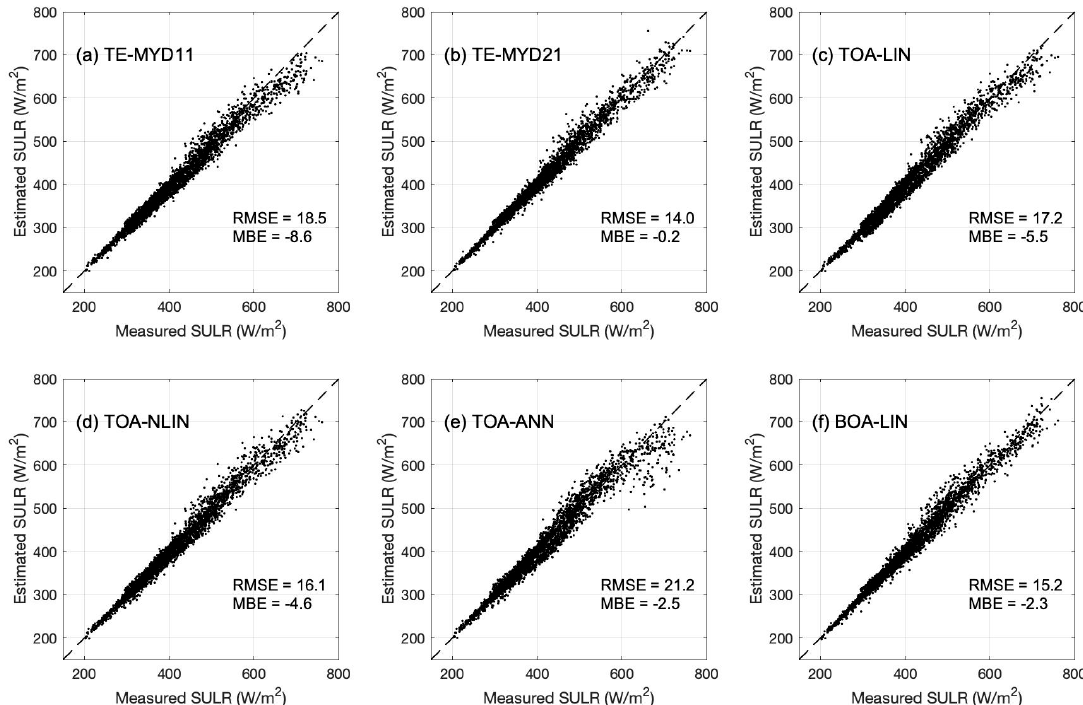
Figure 5. Scatterplots between estimated SULR and corresponding in situ SURFRAD measurement for all six methods. ( a ) TE-MYD11. ( b ) TE-MYD21. ( c ) TOA-LIN. ( d ) TOA-NLIN. ( e ) TOA-ANN. ( f ) BOA-LIN.